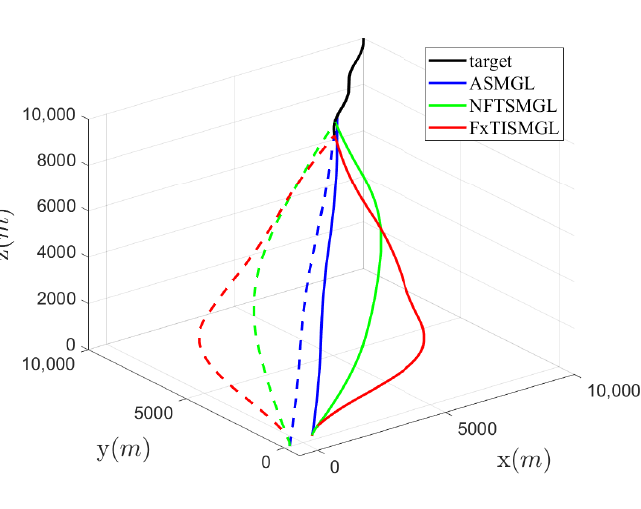
Figure 4. Three-dimensional interception trajectories under different guidance laws. Solid line: missile1, dashed line: missile2.